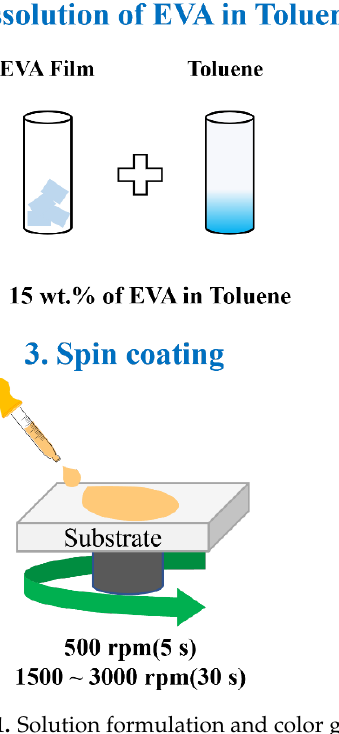
Figure 1. Solution formulation and color glass fabrication process.